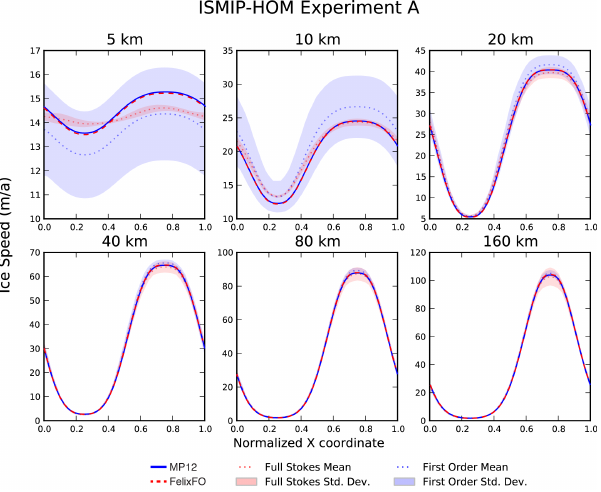
Figure 6. ISMIP-HOM test A: surface velocity component u as a function of x at y = L/ 4 for each L considered. The blue solid line (MP12) represents results from Perego et al. (2012) and the red dashed line (labeled FelixFO) represents results from the current solver.